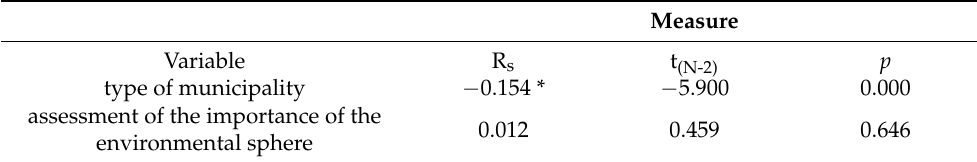
Table 6. Values of R–Spearman correlation coefficients between the impact of negative envi- ronmental phenomena and the type of municipality and the surface area of green spaces in urban–rural municipalities.